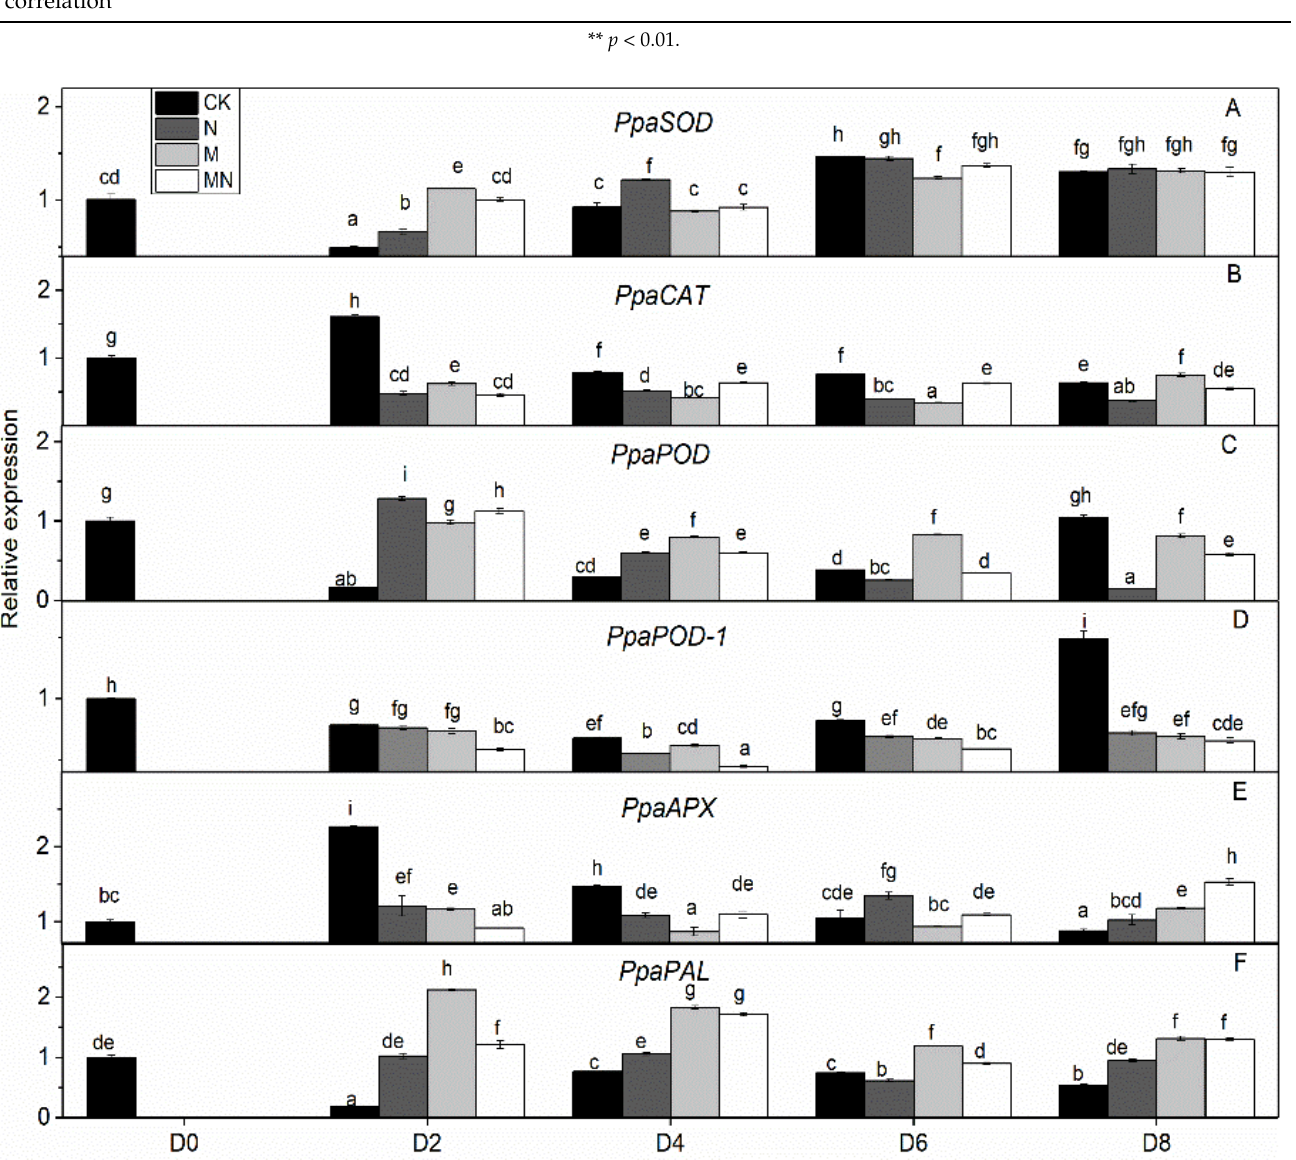
Figure 3. Gene expression profile in peach fruit including PpaSOD ( A ), PpaCAT ( B ), PpaPOD ( C ), PpaPOD-1 ( D ), PpaAPX ( E ) and PpaPAL ( F ). Each point represents means ± SE of three replicates. The lowercase letters indicate significant differences according to statistical analysis.